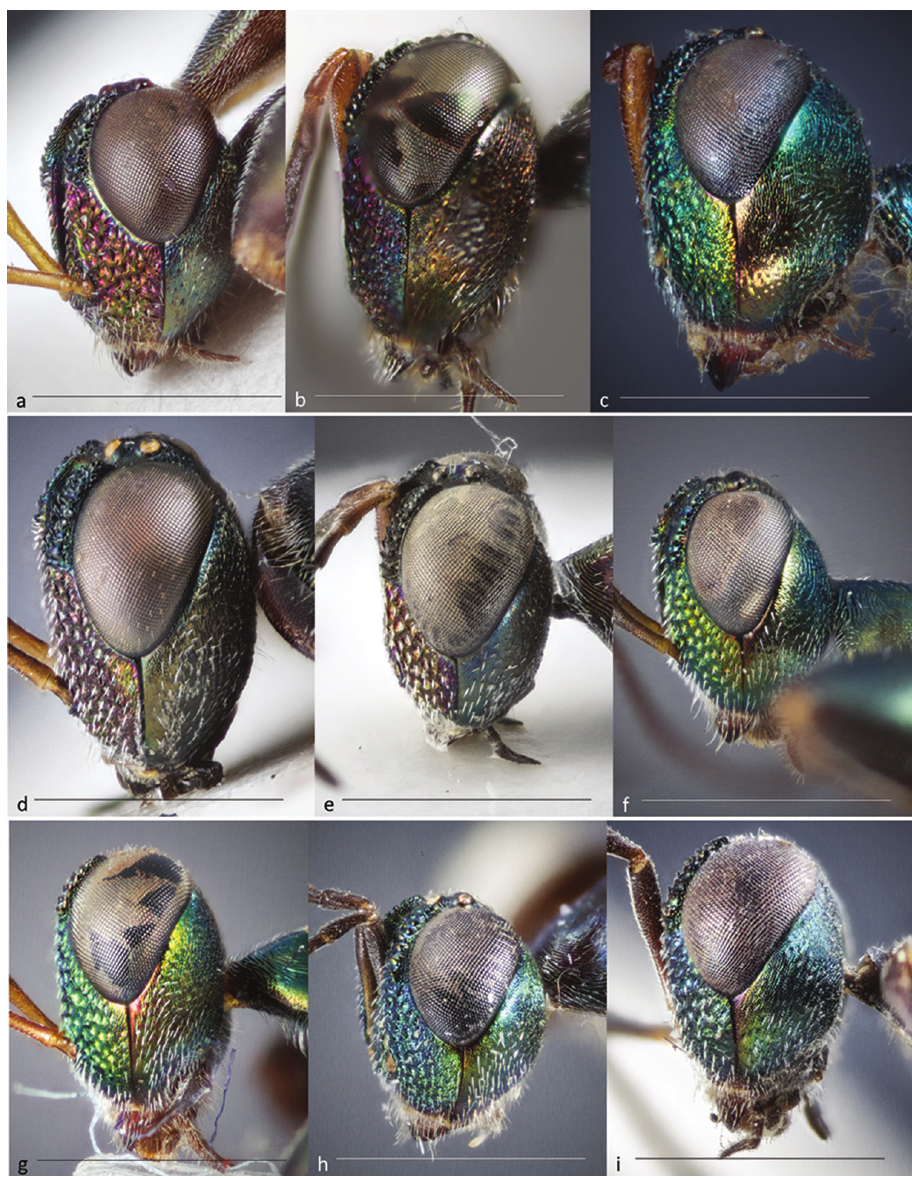
Figure 10. Head (lateral) III a O. magnifica (Risbec) (imaged specimen: OMag01, holotype) b O. mkomaziensis sp. n. (OMk01, holotype) c O. monstrum syn. n. (OFo12, paratype) d O. namibiensis sp. n. (ONa01, holotype) e O. niehuisorum sp. n. (ONi01, holotype) f O. pumilae Yang (OPu01, paratype) g O. regiae Yang (ORe01, paratype) h O. srilankiensis sp. n. (OSr01, holotype) i O. tenuicollis (Walker) (OTe01, holotype). Scale bars: 1